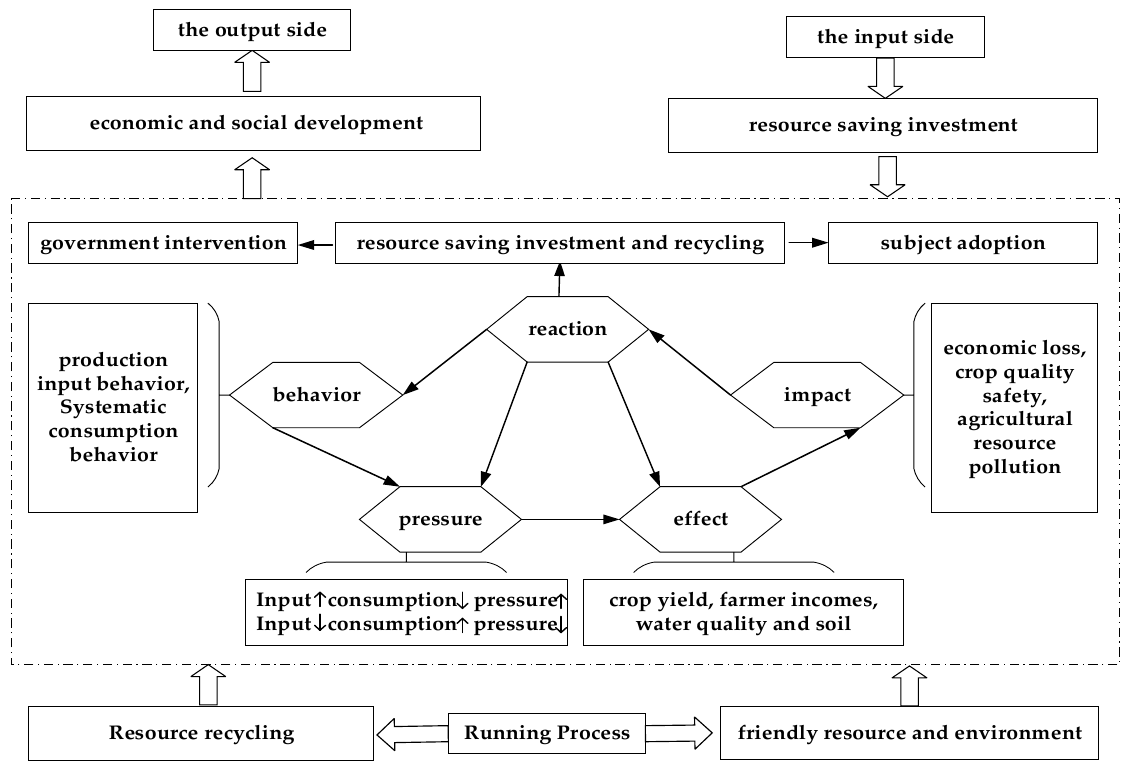
Figure 2. Conceptual model of BPEIR.